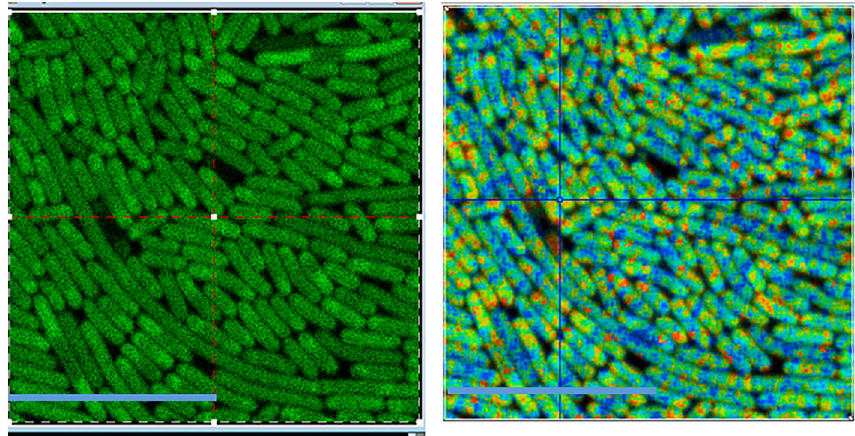
Figure 8. E. coli expressing VNp2-mNeonGreen fusion protein at differing protein concentrations. Left: confocal image. Right: FLIM map. A decrease in the mNeonGreen lifetime from 2.8 to 2.4 ns is seen in higher expressing cells, indicating significant viscosity change. Scale bar 10